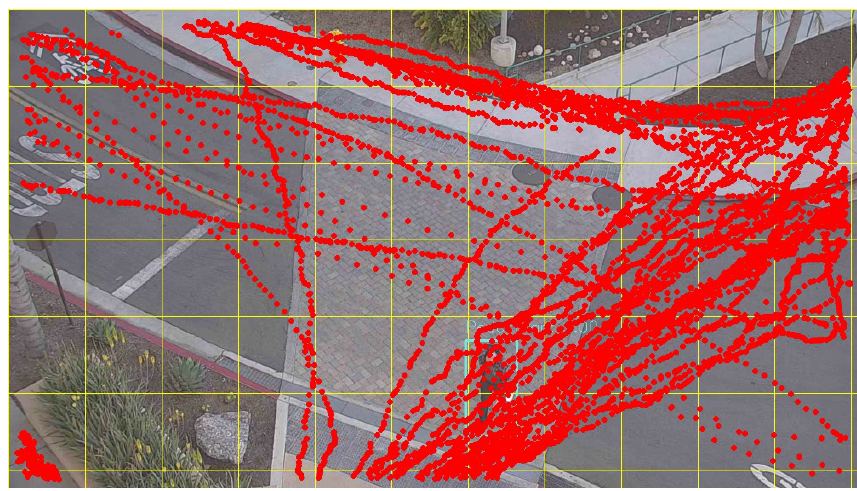
Figure 31. Contrails of only pedestrians and skateboarders recorded after running on video for sometime.